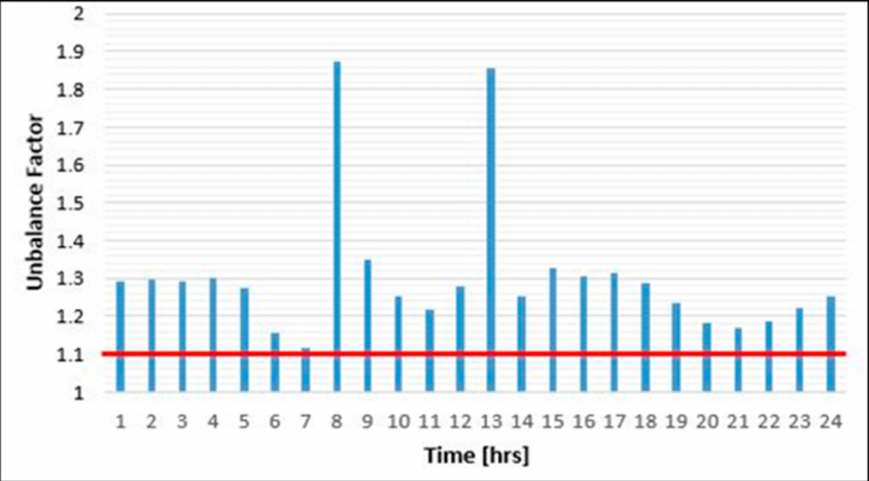
Figure 11. The aggregated phase currents at the level of the CCP (W-PLB case).